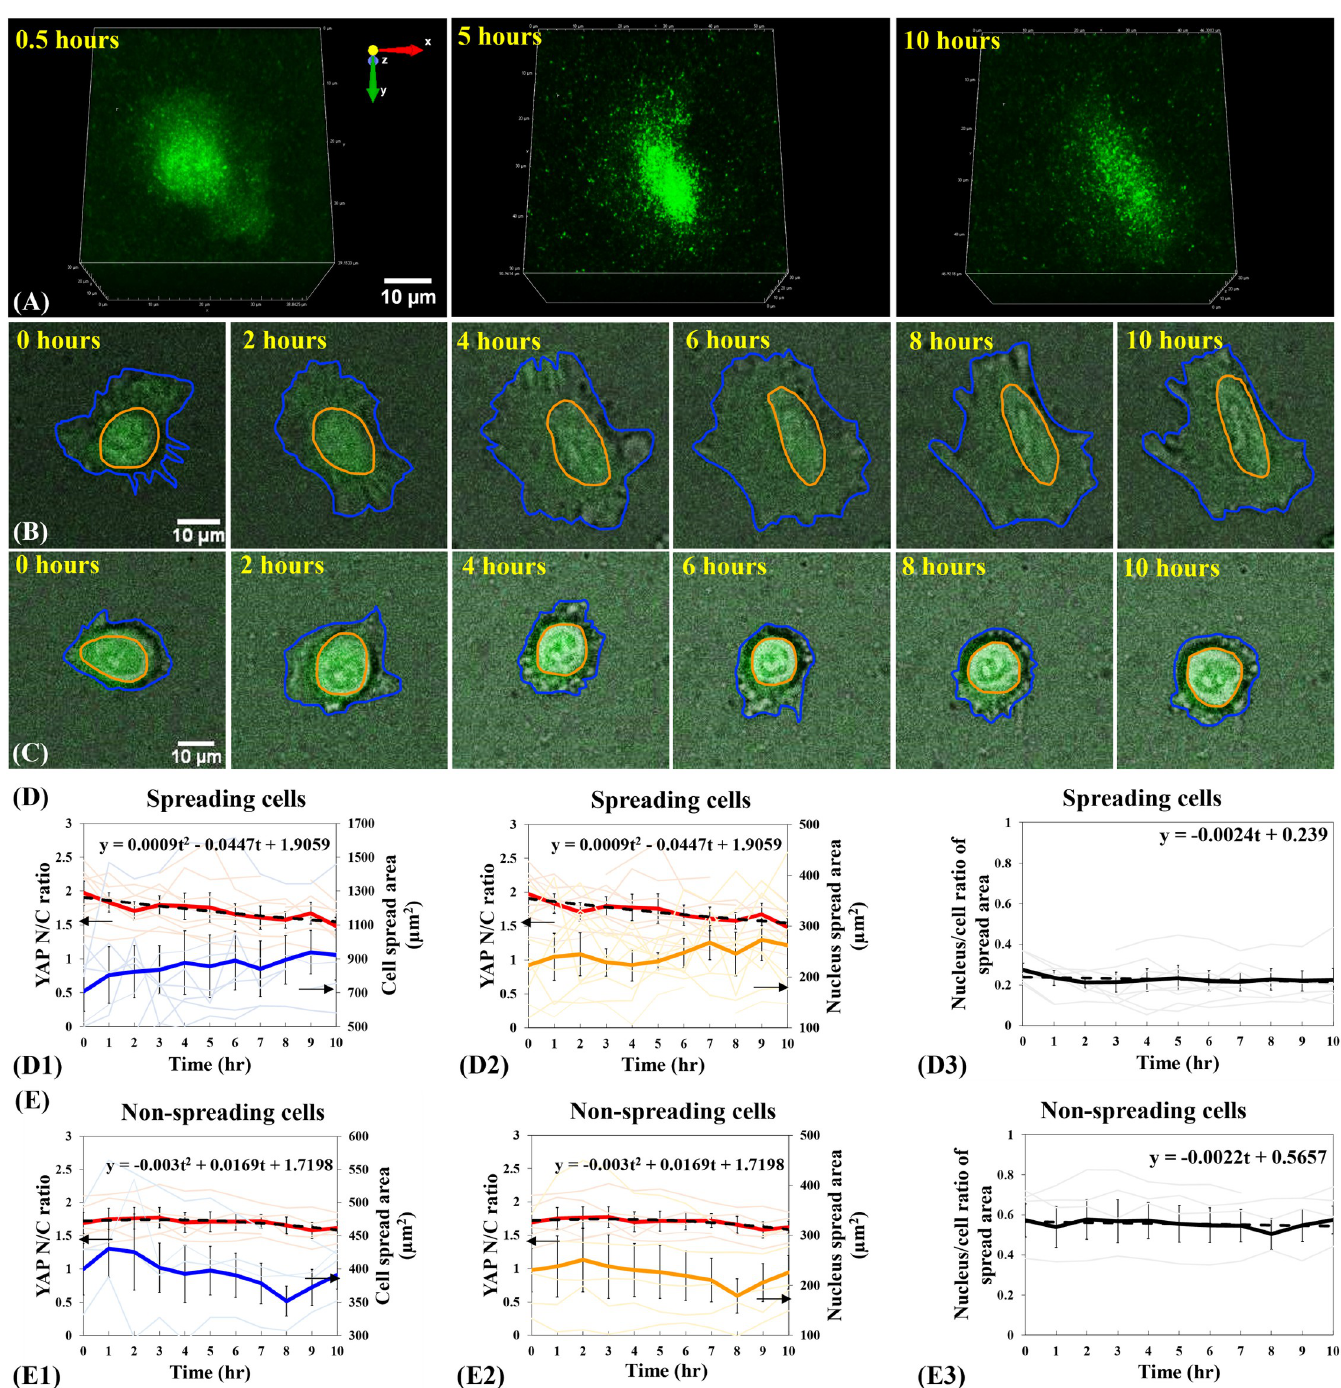
Fig 3. Relationship between YAP N/C ratio and cell spreading states of single B2B cells on 2-kPa hydrogels substrates. ( A ) 3D fluorescent confocal YAP image stack of a single spreading B2B cell on 2-kPa substrate at 0.5 th , 5 th , and 10 th hour. Notably, YAP intensity in nucleus decreases with respect to that in cytoplasm and the YAP distribution becomes homogenous during the process of cell spreading. ( B ) 10-hr time-lapse image stack that contains overlapped fluorescent YAP images and bright-field cell images of a single B2B cell spreading on 2-kPa hydrogels. Note: The shapes of the cell (in blue contour) and nucleus (in orange contour) transform from roundness to flatness. YAP N/C ratio decreases from 1.93 at 0th hour to 1.40 at 10th hour. ( C ) 10-hr time-lapse image stack of a non-spreading single cell. Note: The shape of the cell maintains rounded. YAP N/C ratio changed from 1.62 at 0th hour to 1.59 at 10th hour. ( D ) YAP N/C ratio versus nucleus/cell-body area of spreading cells (n = 10). The average YAP N/C ratio (red bold line; n = 10) changed from 1.97 ± 0.17 to 1.49 ± 0.12 (p-value = 0.0022 �� ; D1 ). The average cell area (blue bold line; n = 10) increased